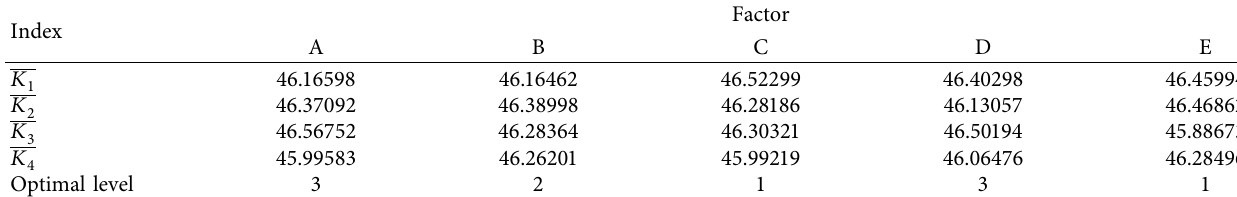
Table 9: Weighted index extreme deviation table.